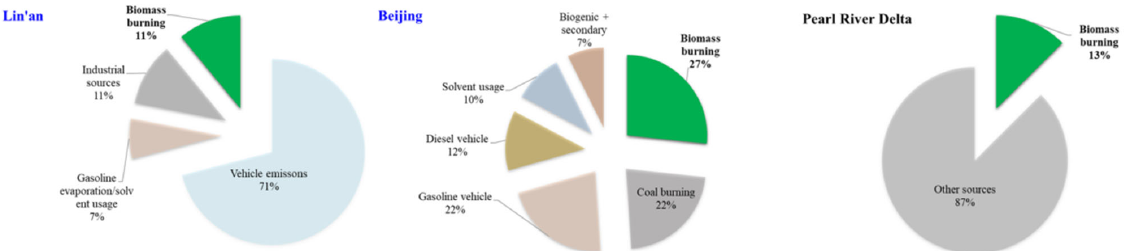
Figure 4. Contributions of biomass to VOCs.